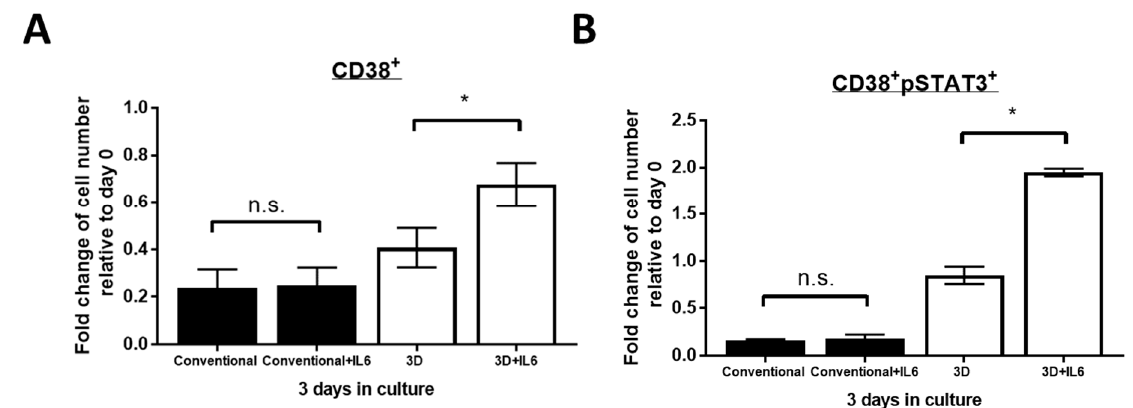
Figure 4. IL6 improved PM cell viability in 3D but not in conventional culture. Fold change of viable ( A ) CD38+ and ( B ) CD38 + pSTAT3+ cell number from 3 MM patients in conventional or 3D culture on day 3 relative to day 0. 30 pg/mL IL6 was added to cells every 24 h for 3 days. The mean value was indicated with error bars representing standard error. n.s. not significant, * p < 0.05, paired Student’s t -test.